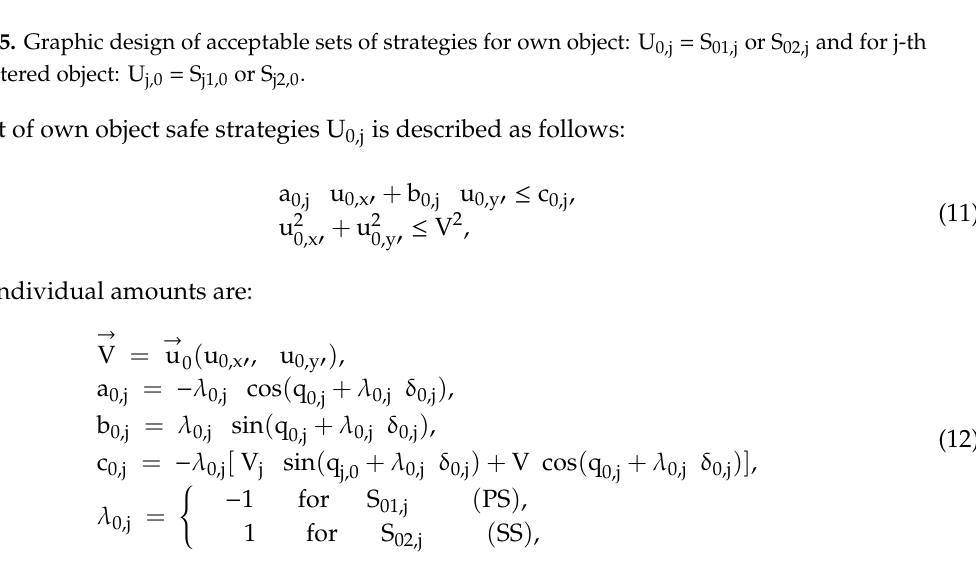
= S or S and for j-th 0,j 01,j 02,j